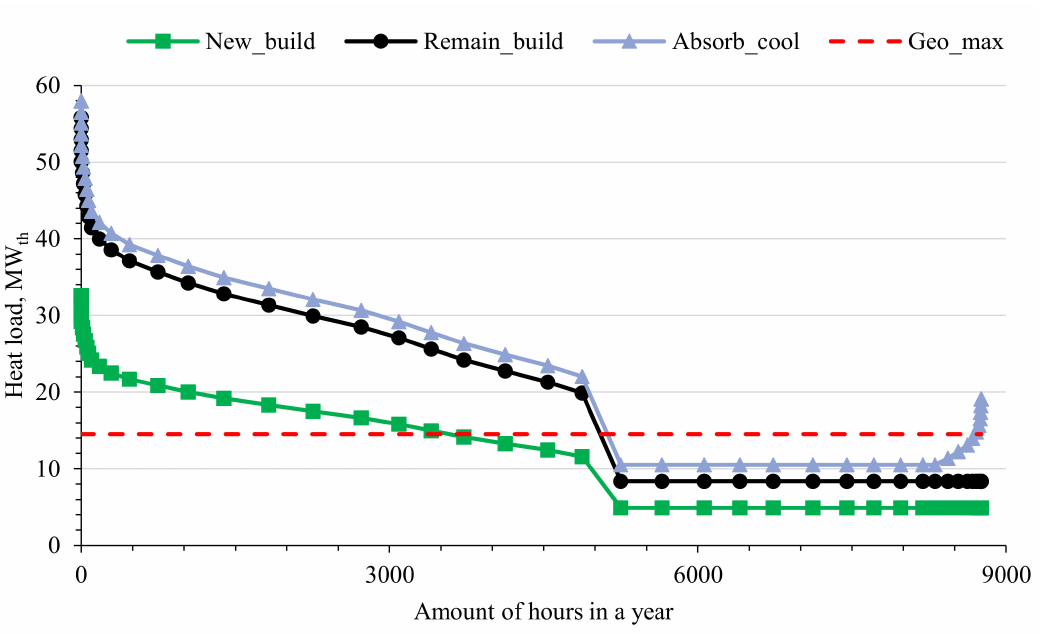
Figure 2. Expected heat load duration curve after reconstruction of the campus (including to-be-built buildings, remaining existing buildings, and heat for absorption cooling) in comparison with the estimated maximum geothermal output. Note: absorption cooling is assumed to be constant throughout the year, except for summer peak.